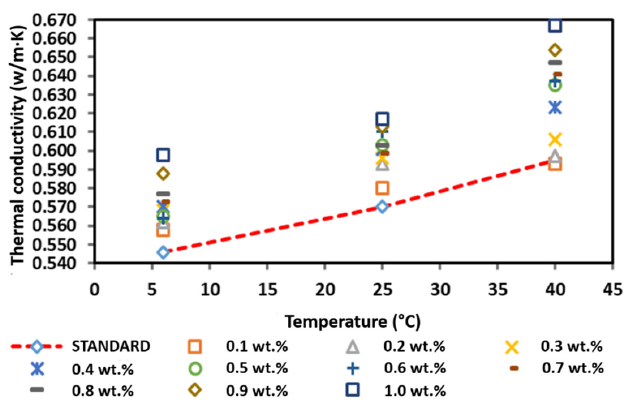
Figure 14. Comparison of the thermal conductivity between the commercial CNF ‐ based nanofluids without PVP and the pure base fluid at various concentrations and temperatures. Table 6. Thermal conductivity enhancement of the commercial CNF ‐ based nanofluids without PVP. Weight Concentration of Commercial CNFs (wt.%)